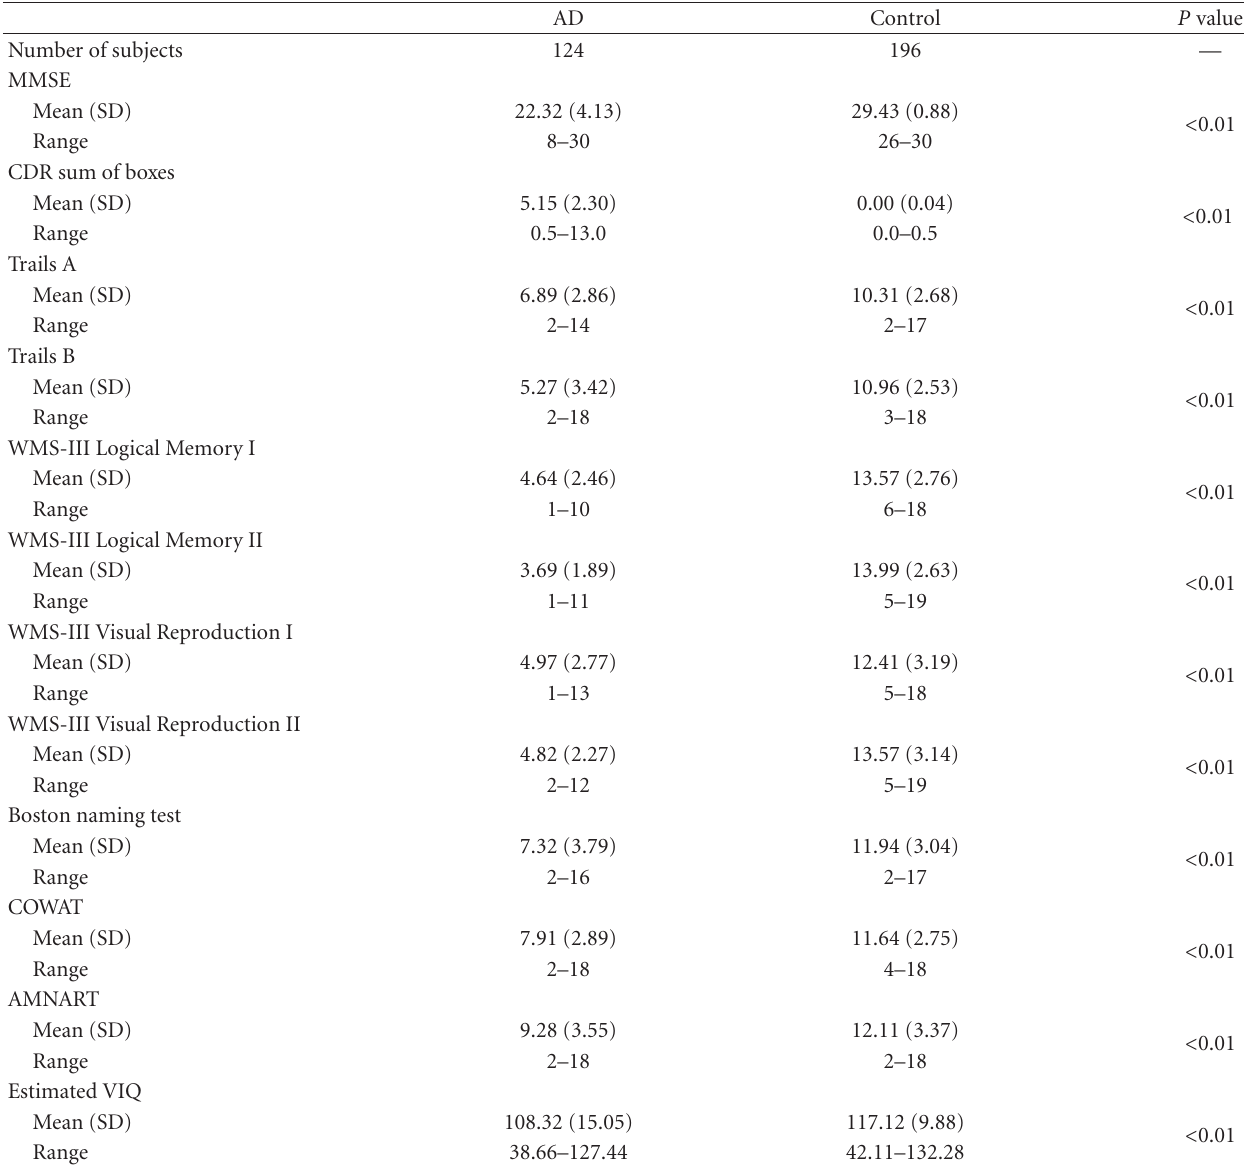
Table 3: Neuropsychological testing by